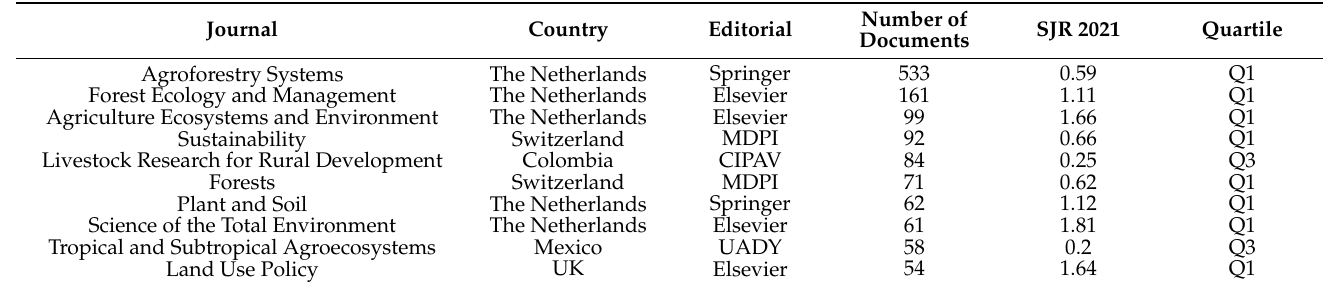
Table 2. Ranking of journals by number of publications in silvopastoral